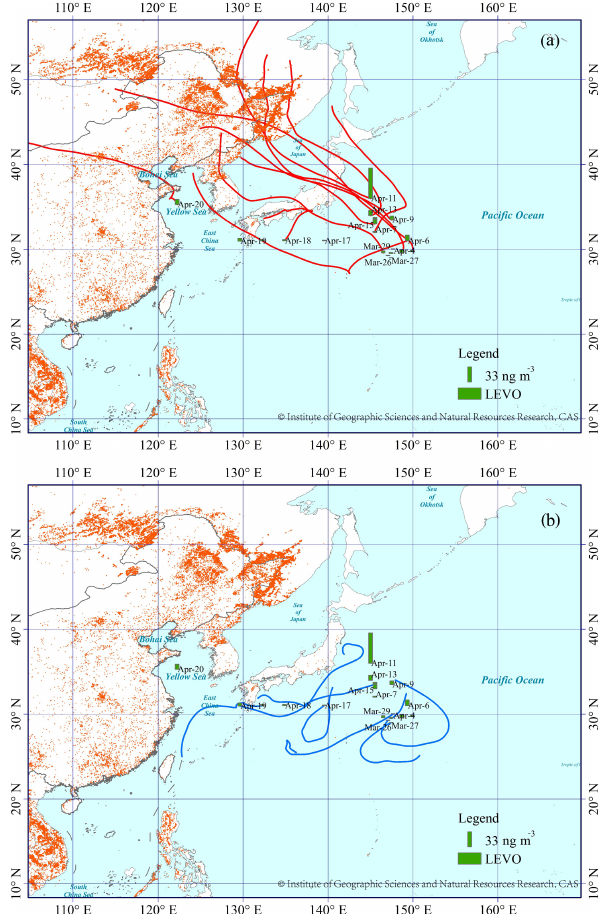
Figure 1. The spatial distribution of LEVO in TSP over the NWPO in spring of 2014, and the 72h back trajectory associated with each TSP sample. (a) The red lines represent that air masses can be derived from the continent (Category 1); (b) the blue lines rep- resent that air masses may be derived mainly from the oceans (Category 2). The red dots represent the locations of fires from Fire Information for Resource Management System (FIRMS; https: //firms.modaps.eosdis.nasa.gov/, last access: 24 April 2020). The base map was sourced from the Resource and Environment Data Cloud Platform (http://www.resdc.cn/DOI/doi.aspx?DOIid=56, last access: 24 April 2020), © Institute of Geographic Sciences and Natural Resources Research, Chinese Academy of Sciences (CAS). The data from the Resource and Environment Data Cloud Platform are open-access and free. (Please note that the above figure contains disputed